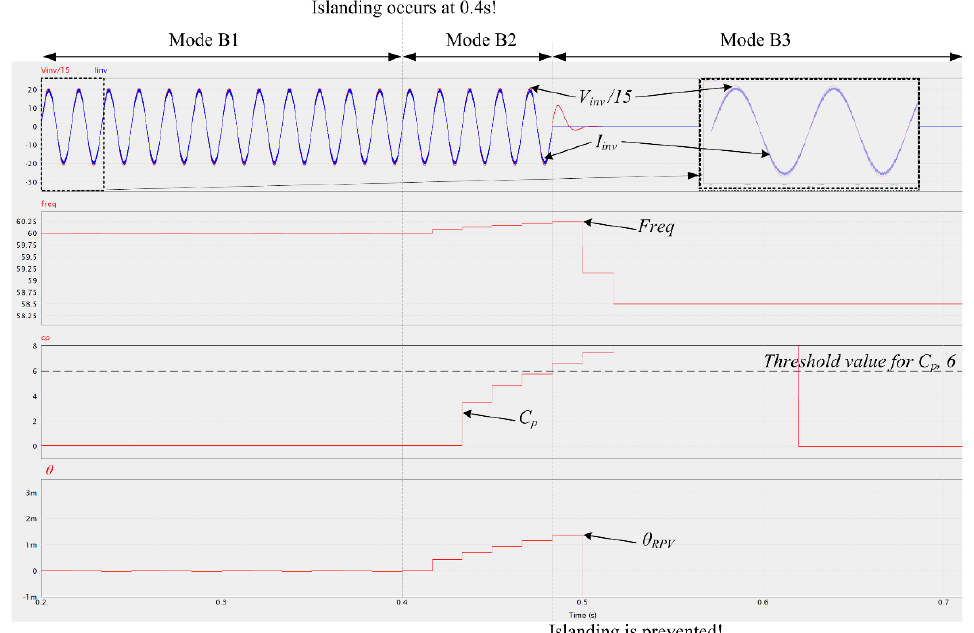
Figure 6. Anti-islanding test results for the proposed method with tripping.